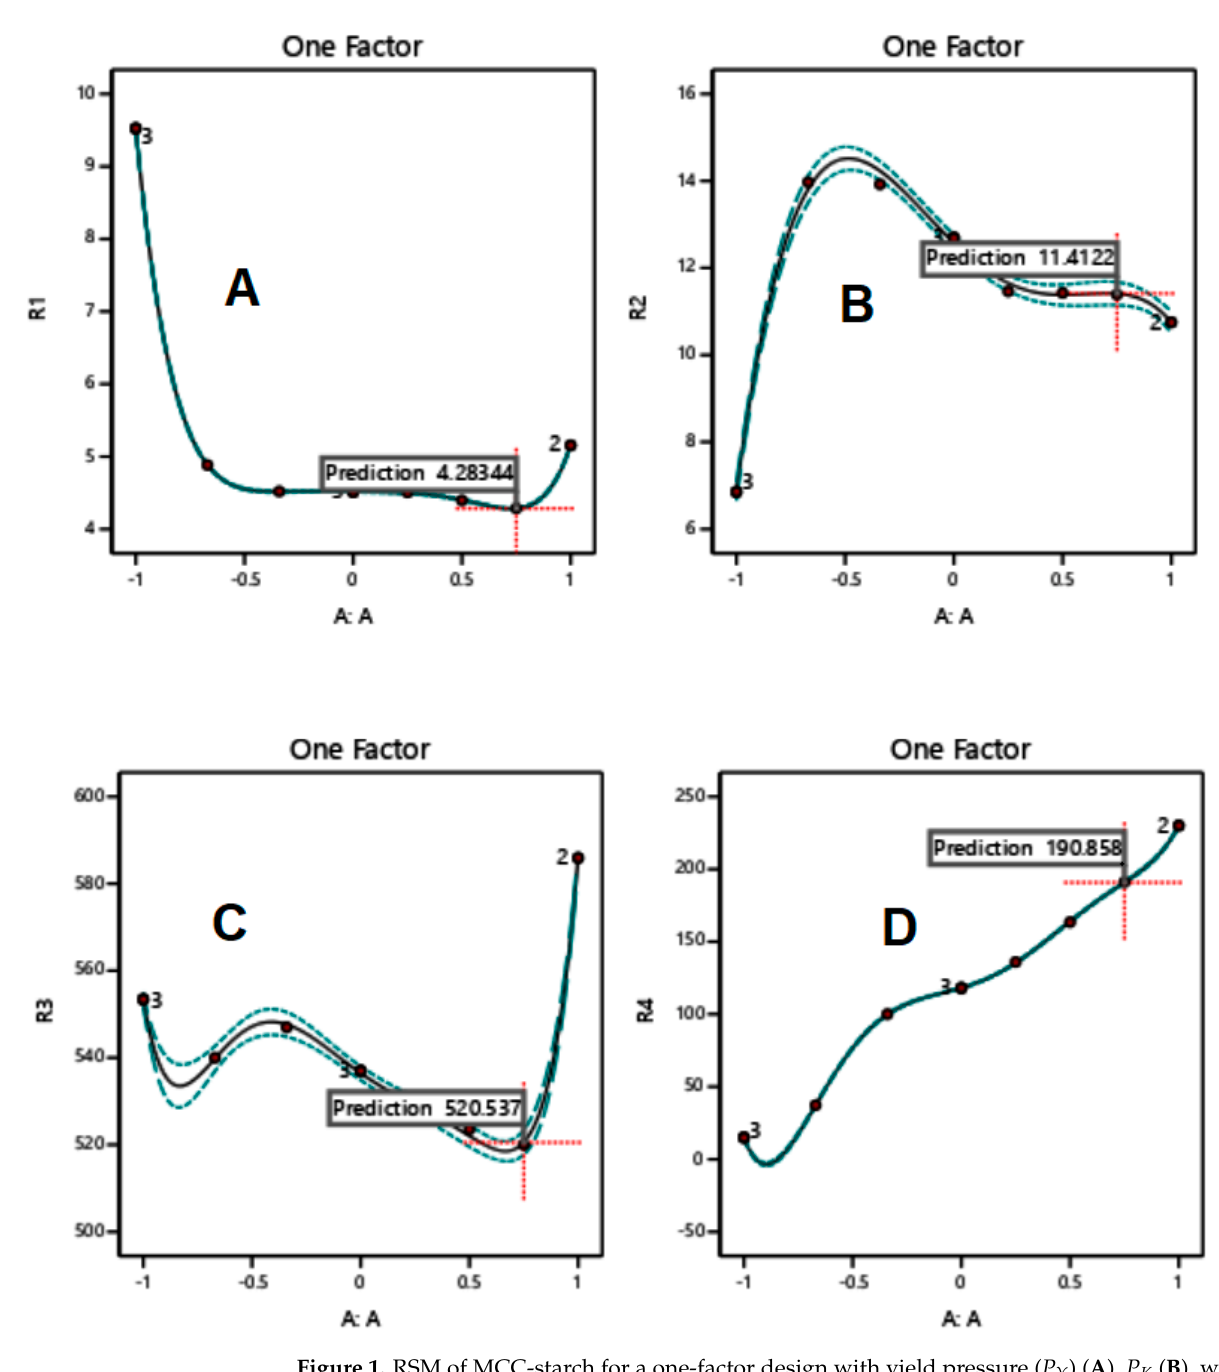
Figure 1. RSM of MCC-starch for a one-factor design with yield pressure ( P Y ) ( A ), P K ( B ), work of compression ( C ), and tablet hardness ( D ) as the responses.